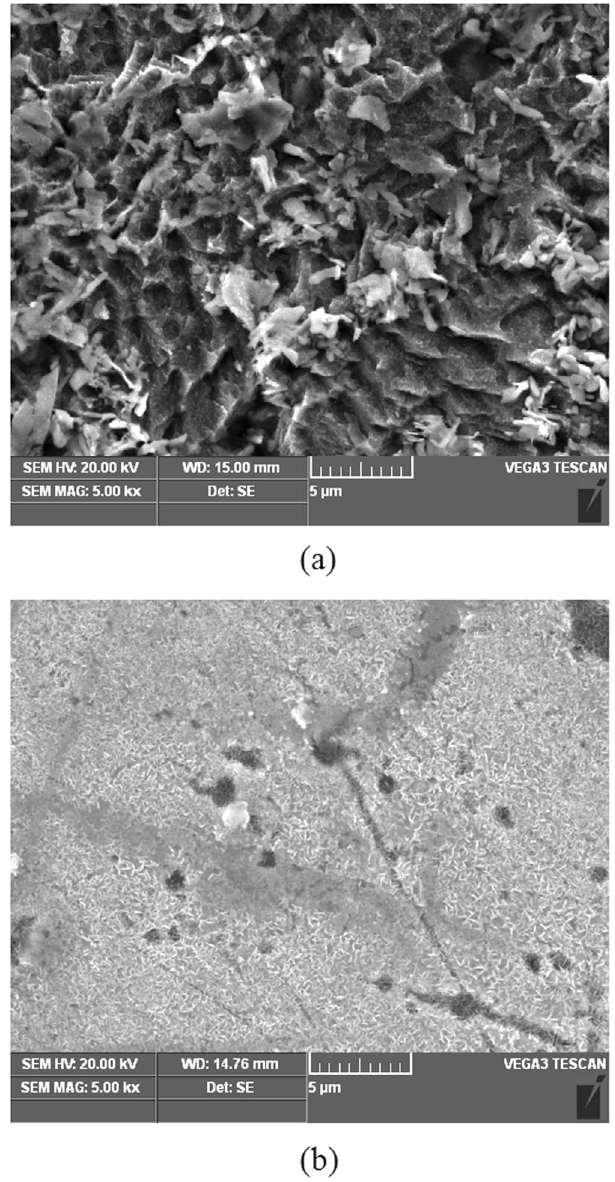
Figure 8. SEM micrographs of mild steel surface after immersed in 0.5 M H 2 SO 4 solution in the absence of LLE ( a ) and in presence of 100% V/V LLE ( b ) for 4 h at 298